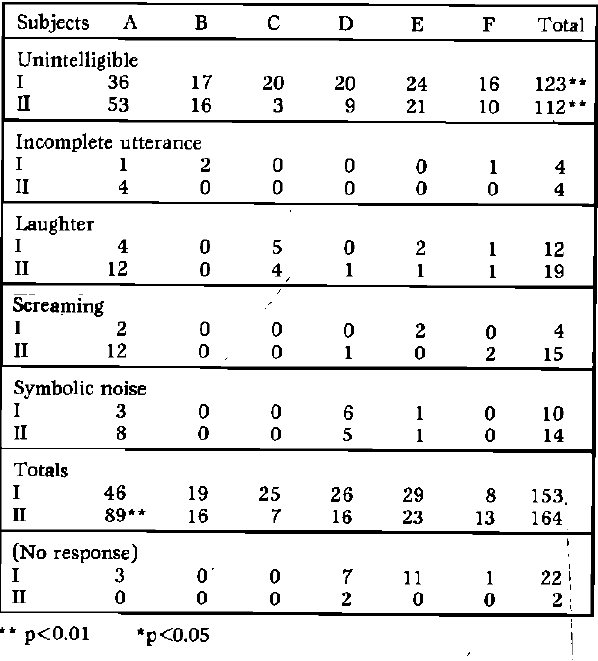
Table 4: Variation within the "Other" category for all sub- jects in Interactions I and